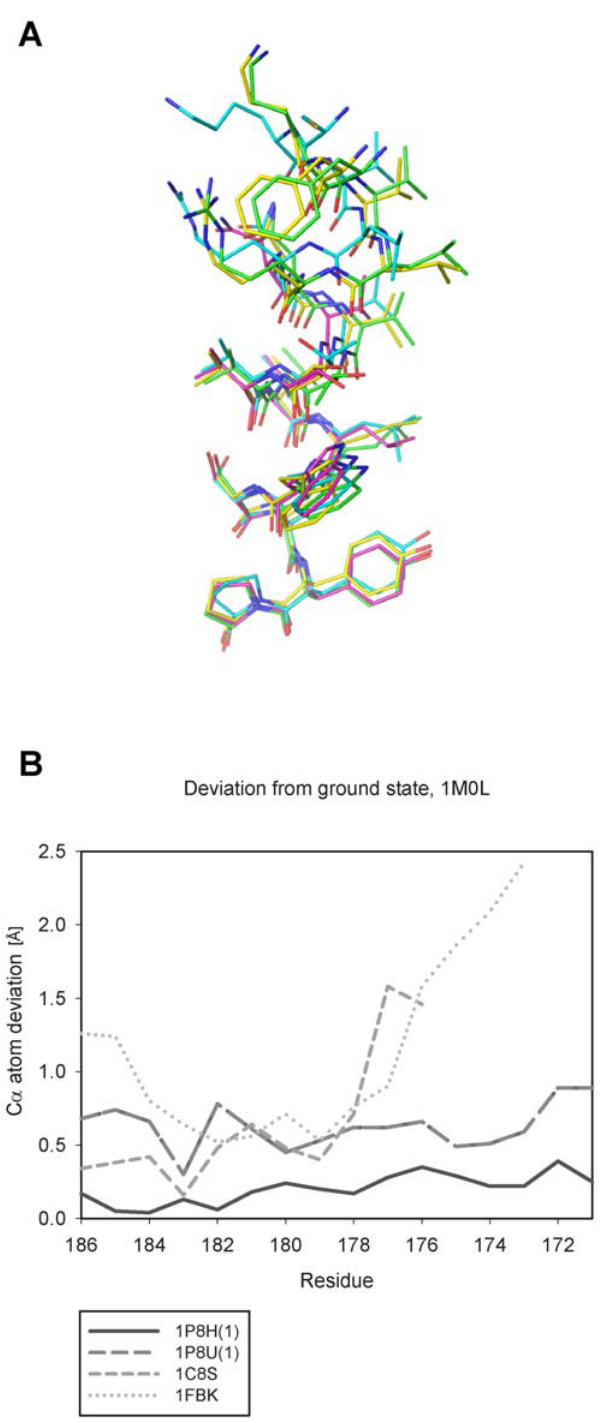
Figure 4. Superposition and C a atom deviation of the helix F region from M 1 to N 9 intermediates. (A) Superposition of the helix F region from M 1 to N 9 intermediates. Residues 171–186 of 1P8H(1), 1P8U(1), 1C8S, and 1FBK are extracted and displayed as ‘‘lines’’ modeled in Pymol. Residue number increases from top (cytoplasmic side) to bottom (periplasmic side) showing larger deviations around the cytoplasmic side. (B) C a atom deviation of M 1 to N 9 states from ground state coordinates, 1M0L at each atom position in helix F. 1C8S lacks the cytoplasmic side of helix F.